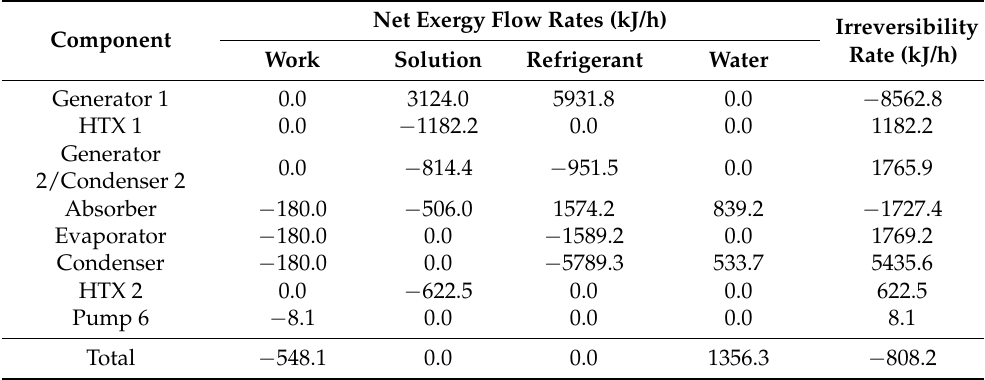
Table 8. Exergy balance for each component in industrial double effect LiBr–water absorption refrigeration system shown in Figure 2 (Cooling capacity is 6.0